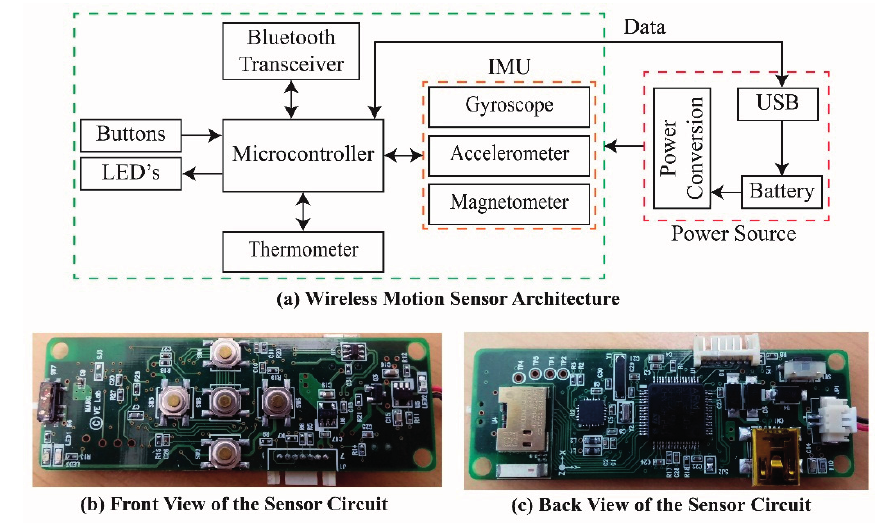
Figure 2. Wireless motion sensor